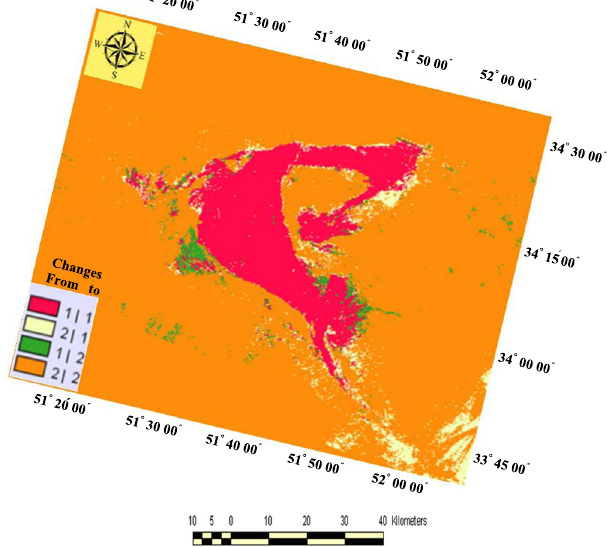
Figure 5. Changes detected between two Landsat TM images using the cross-tabulation module. Red represents the Rigboland sand sea area without change. The yellow and green show areas added to and diminished from the Rigboland sand sea from other geomorphological features and land uses (i.e. residential areas, industrial parks, agricultural and orchard lands, rangelands) respectively over the period from 1988 to 1998 (Arc GIS software version 10.2).